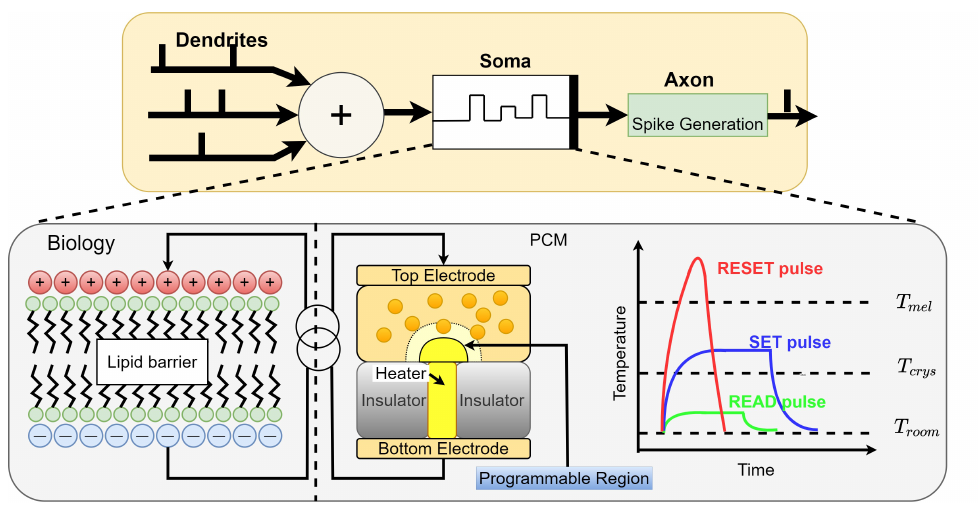
Figure 3. Spiking neuron with PCM. The physical properties of PCM can be used to emulate the dynamics of biological neurons. In this example, a PCM device is used to model current integration and the nonlinear neuron spiking behavior